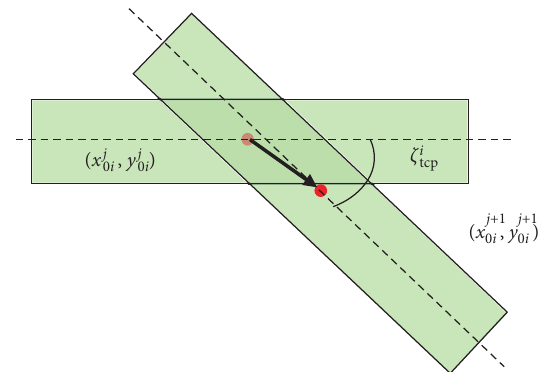
Figure 6: The center coordinates and angle changes.